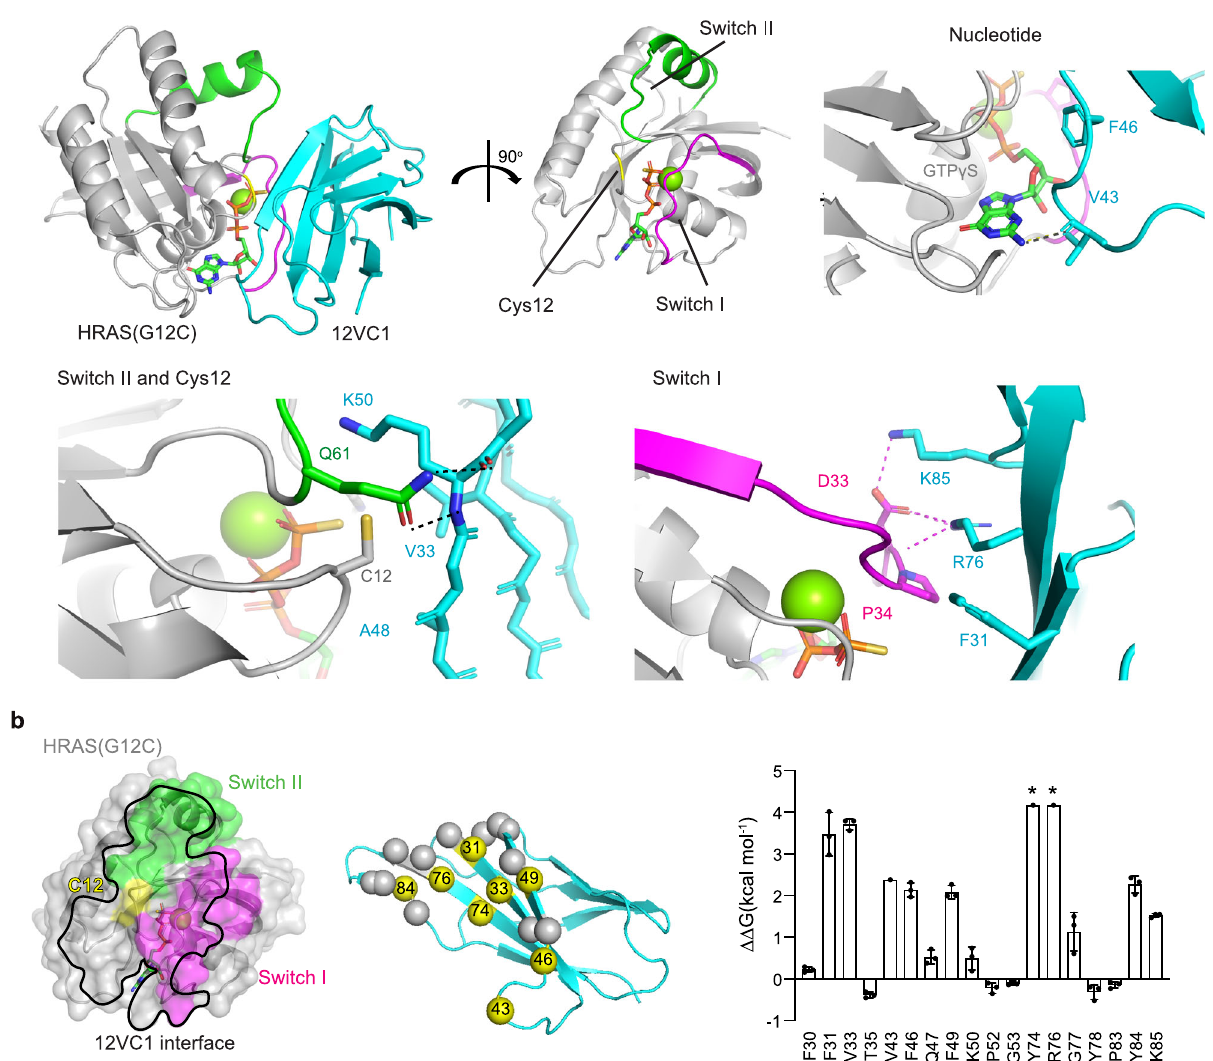
Fig. 2 Structural basis for mutant-selective recognition of RAS by 12VC1 monobody. a Crystal structure of 12VC1 (cyan) in complex with HRAS(G12C) bound to GTP γ S (gray) at 2.54Å resolution (PDB: 7L0G). Critical interactions between 12VC1 and HRAS(G12C) occur at the switch I (magenta) and switch II (green) regions. Interactions at these regions are expanded for detailed views in separate panels. Residue V43 of 12VC1 forms a hydrogen bound with the nucleotide. Mutated position, Cys12 of RAS (yellow), is accommodated by a pocket that consists of residues V33, A48, and K50 of 12VC1 shown in stick model. Residues R76 and K85 on 12VC1 form hydrogen bond and salt bridges with Switch I residue D33. Residue F31 on 12VC1 forms hydrophobic interactions with Switch I. b An open book view of the HRAS(G12C):12VC1 complex. Effects of alanine mutation of 12VC1 residues located within 4Å of HRAS are shown in the bar graph (mean±SD). Asterisks denote that ΔΔ G is beyond the measurable limit of experiments and thus the values shown represent the lower limit. Experiment was performed in triplicate except for V43, Y74, and R76, and the error bars indicate s.d. The mutated residues in alanine scanning are shown as spheres in the cartoon model, and those for critical residues ( ΔΔ G>2kcal/mol) are colored yellow and labeled (middle